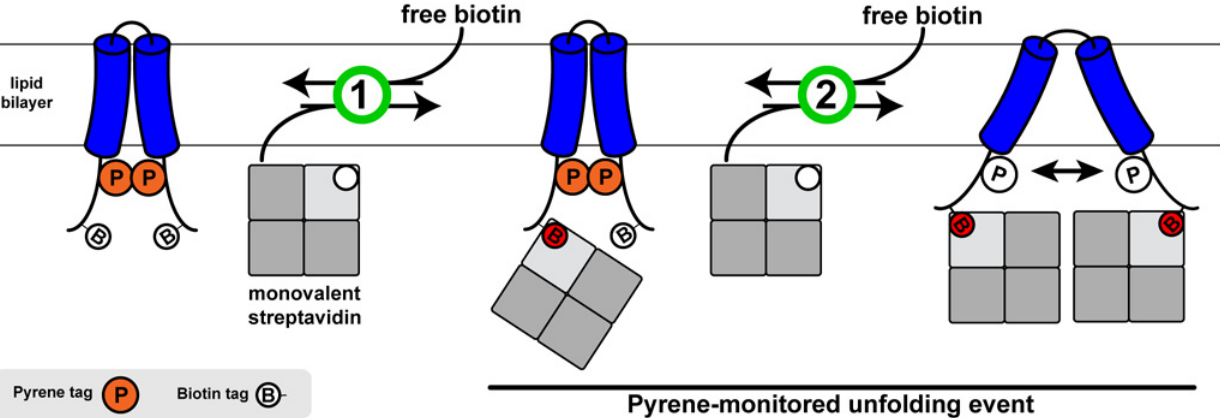
Fig 3. Membrane protein hairpin platform for folding studies. A CFTR TM3/4 variant containing two helix-terminal pyrene tags, along with two water- exposed biotin labels, can be unfolded while inserted in a lipid bilayer in a controlled manner using the high affinity biotin-streptavidin interaction with monovalent streptavidin (mSA). At low mSA concentrations, only one biotin tag is occupied (1), while increasing mSA concentration leads to steric unfolding of the hairpin (2) to allow for the second binding to occur. This process can be reversed by competition with excess free biotin. Using pyrene as a probe